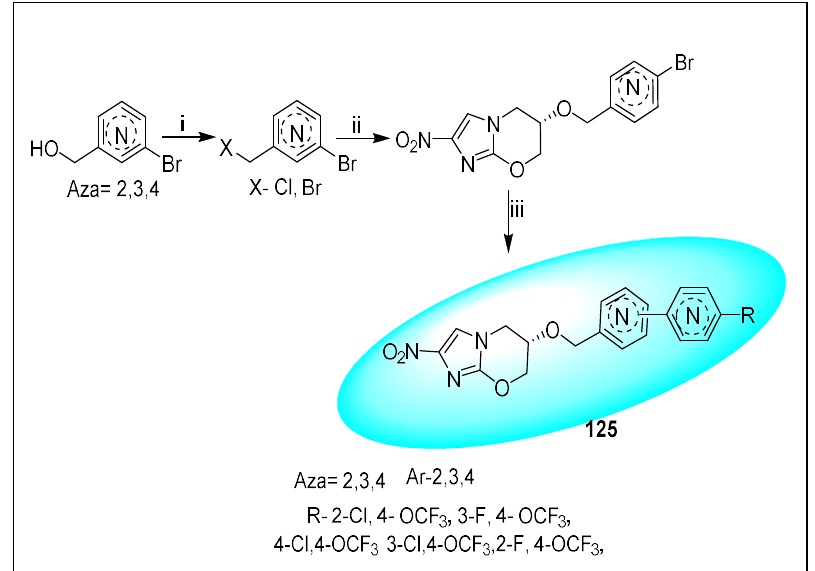
Scheme 78. Synthesis of Aza analogs of PA-824 19 . Reagents and conditions: ( i ) NBS/NCS, PPh 3 ,